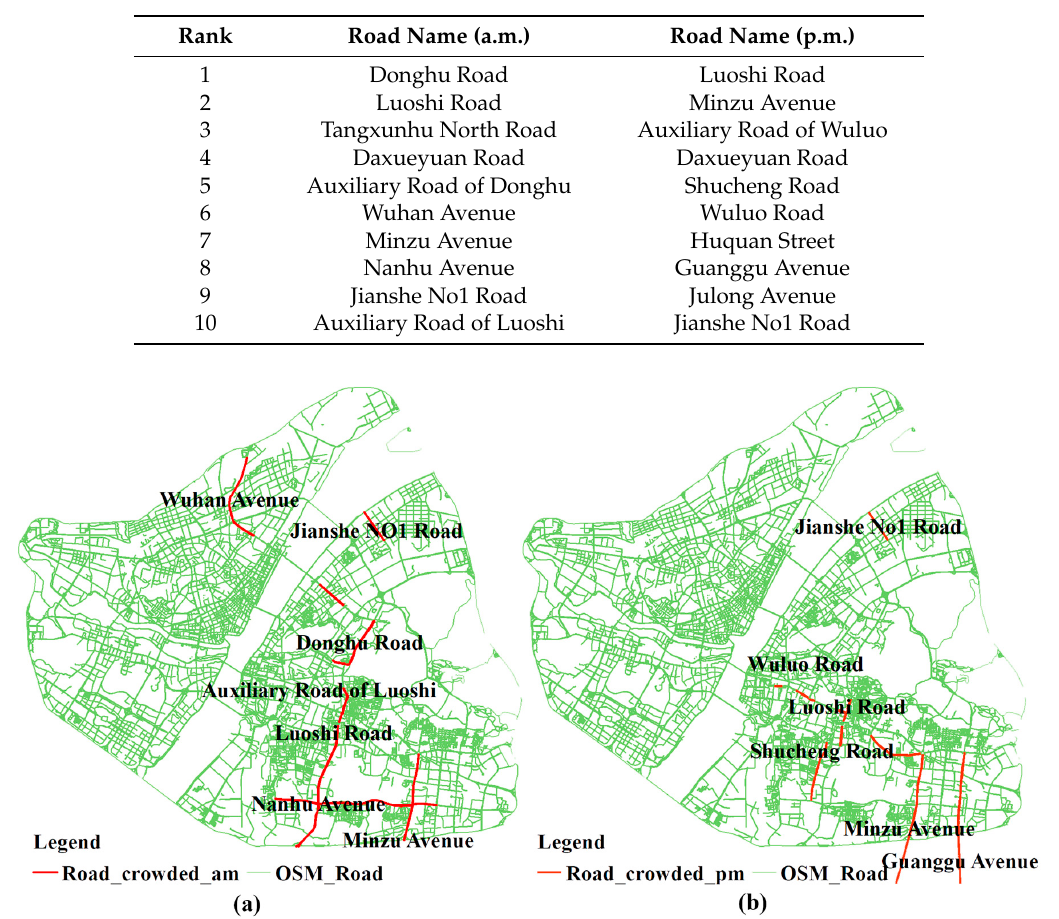
Table 5. The top ten congestion road sections in rush hour provided by the Wuhan Traffic Management Bureau.